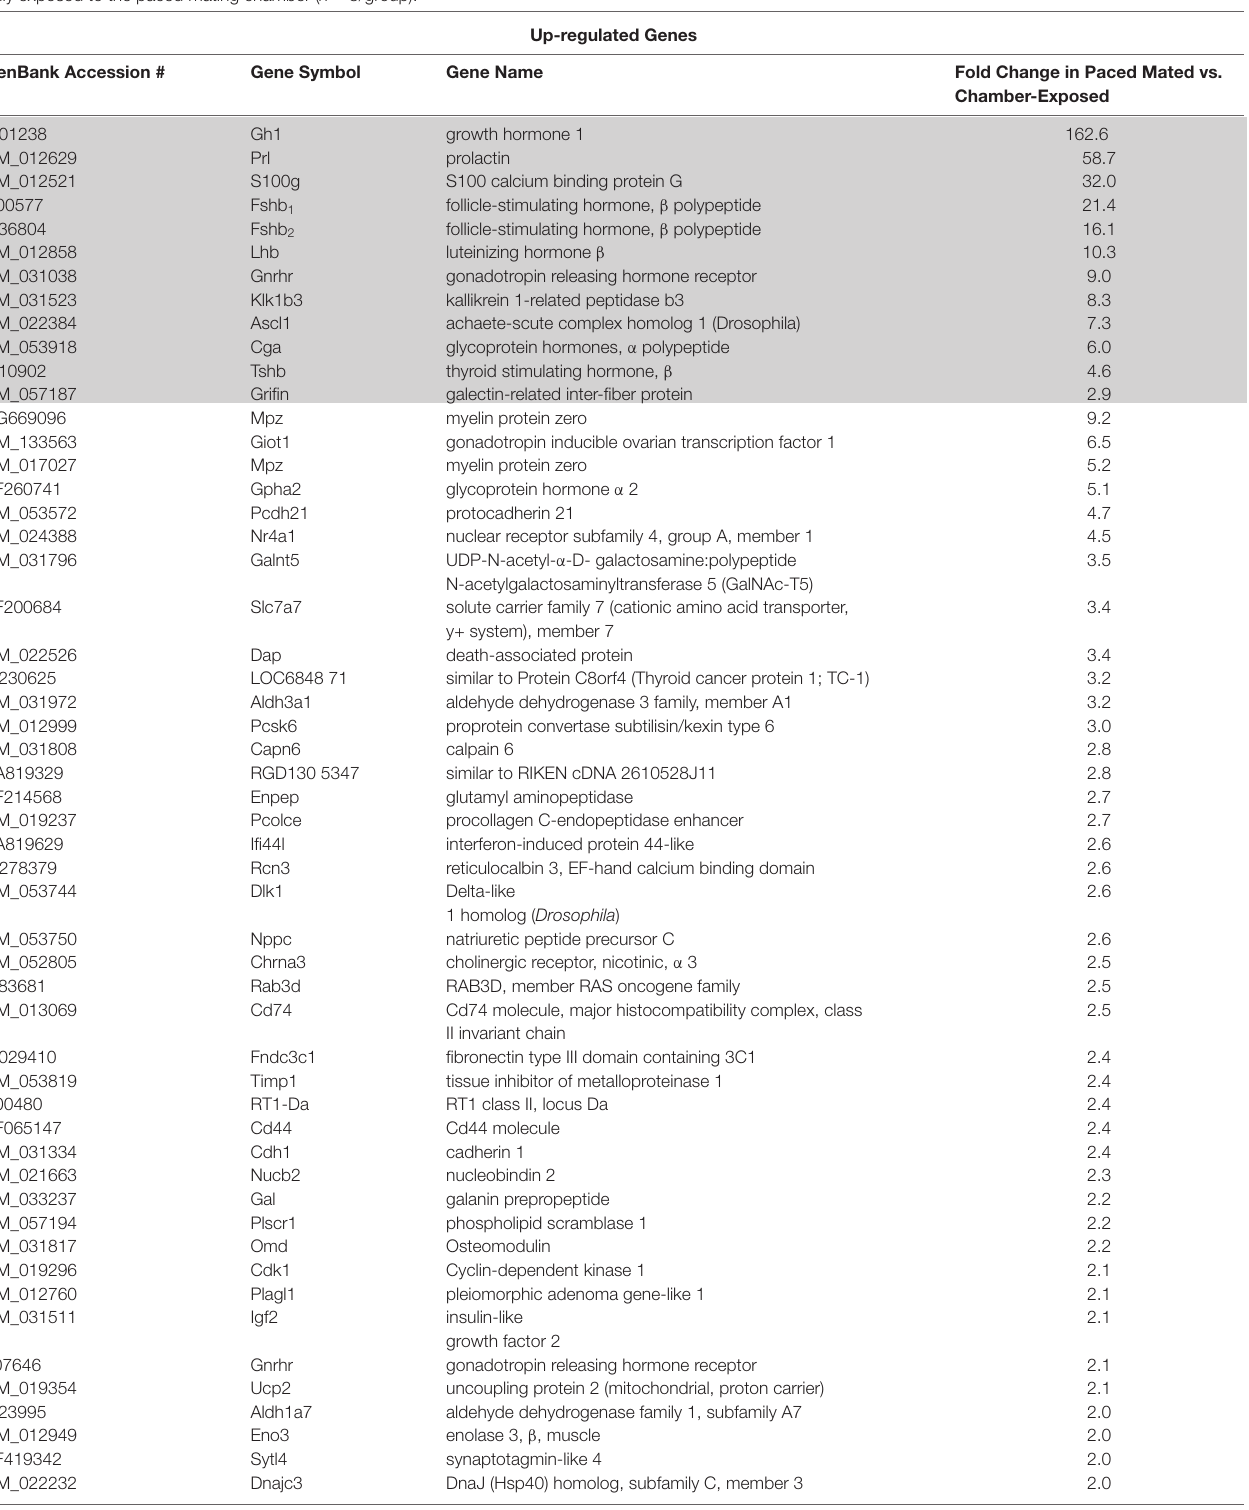
Those highlighted in gray were followed up on with qPCR (see Table 3